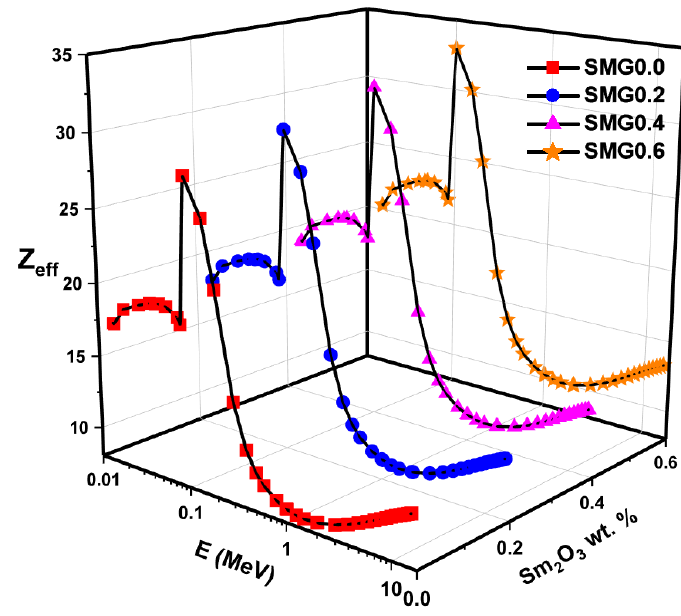
Figure 14. Z eff of glass samples as a function of the photon energy.